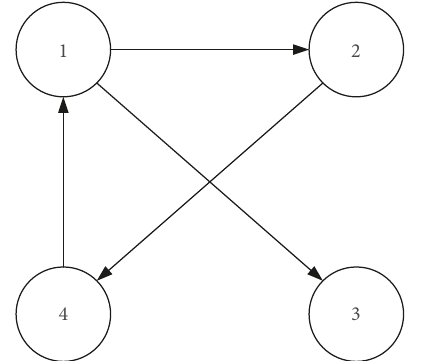
Figure 9: The connected interaction topology in example 2.